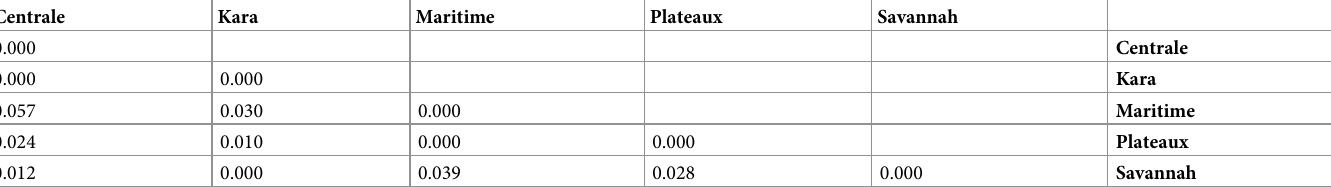
Table 6. Pairwise population Fst values.